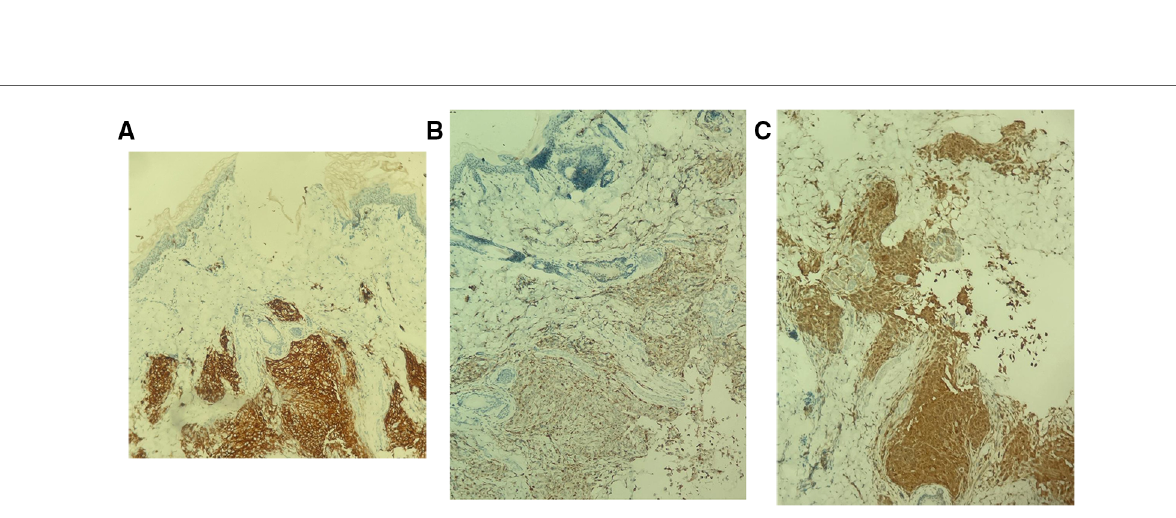
FIGURE 2 Congenital cutaneous langerhans cell histiocytosis. ( A ). Dermal- hypodermal in fi ltration by histocytes (H & E. 20X), ( B ). The lesional cells have abundant, light eosinophilic cytoplasm and irregular nuclei with frequent nuclear folds and grooves (arrows), obscure nucleoli and fi ne chromatin.